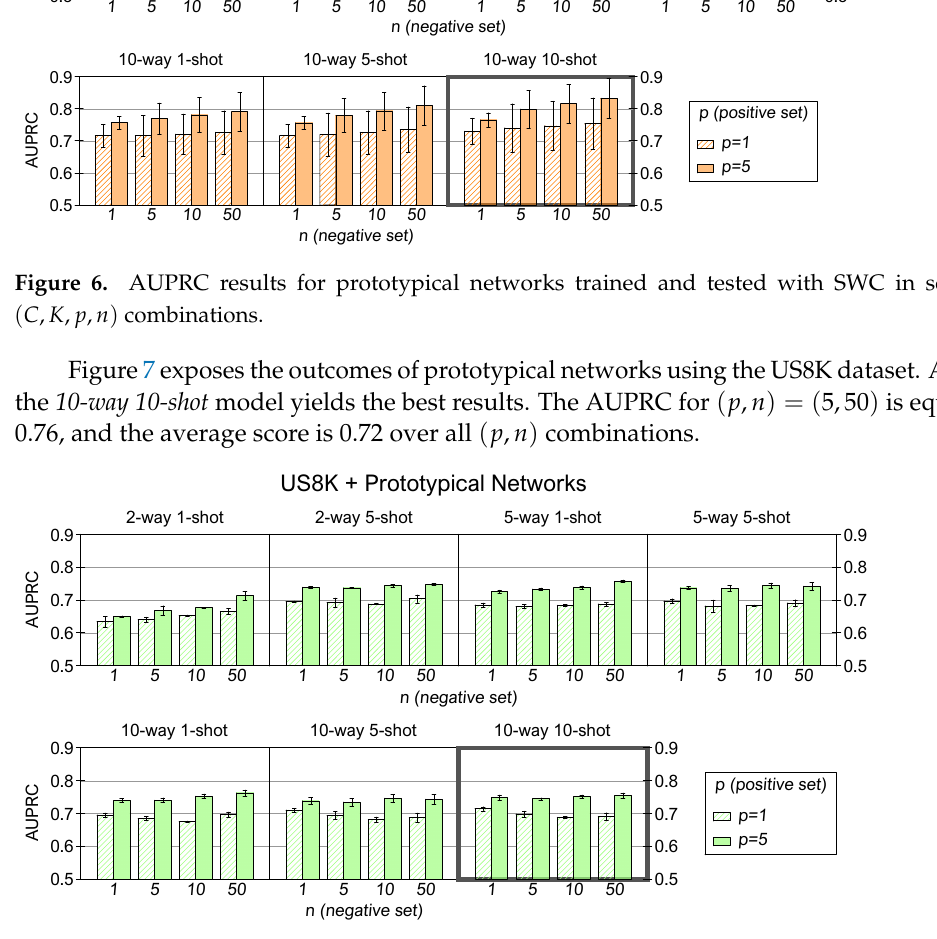
Figure 7. AUPRC results for prototypical networks trained and tested with US8K in several ( C , K , p , n )